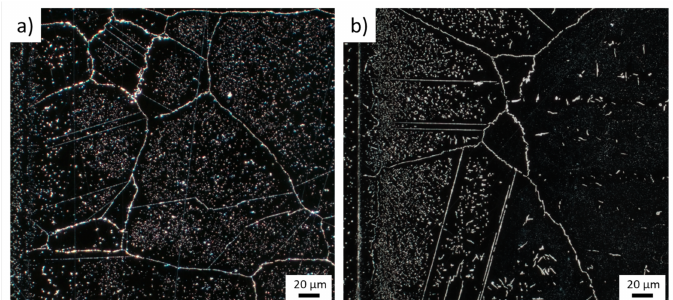
Figure 4. Dark field images of Murakami etched samples showing a dense carbide distribution in the matrix and at grain boundaries for ( a ) the PH steel of composite A and ( b ) the maraging steel of composite B.